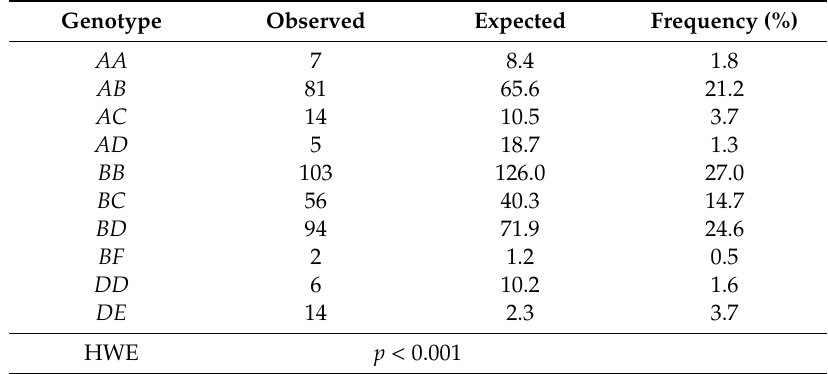
Table 1. Genotype count and Hardy–Weinberg Equilibrium (HWE) test for ovine KRTAP28-1 . Genotype